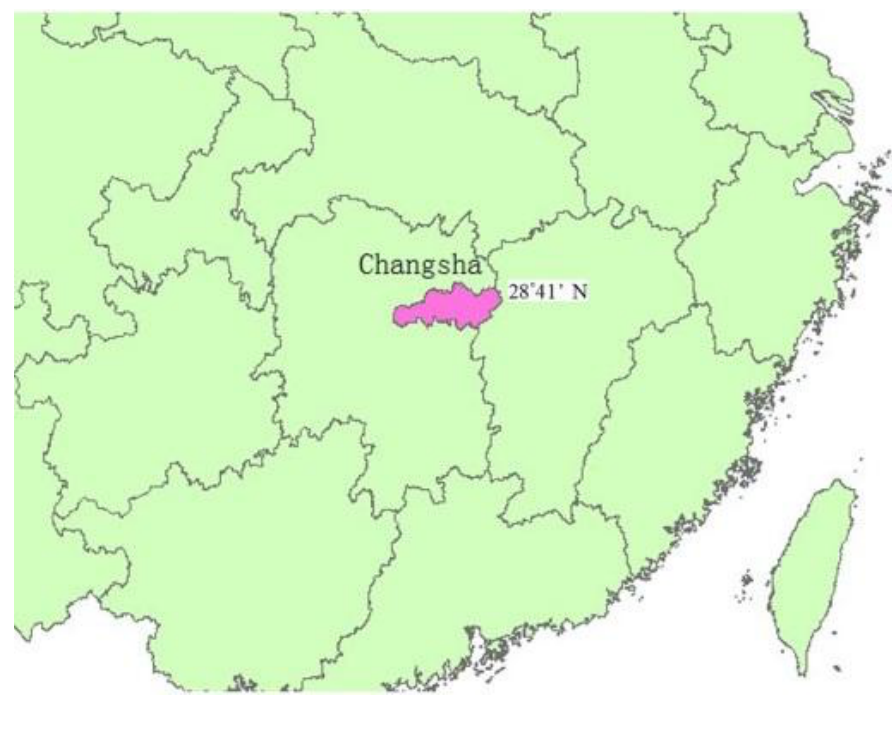
Figure 1. Geographical Location of Changsha in